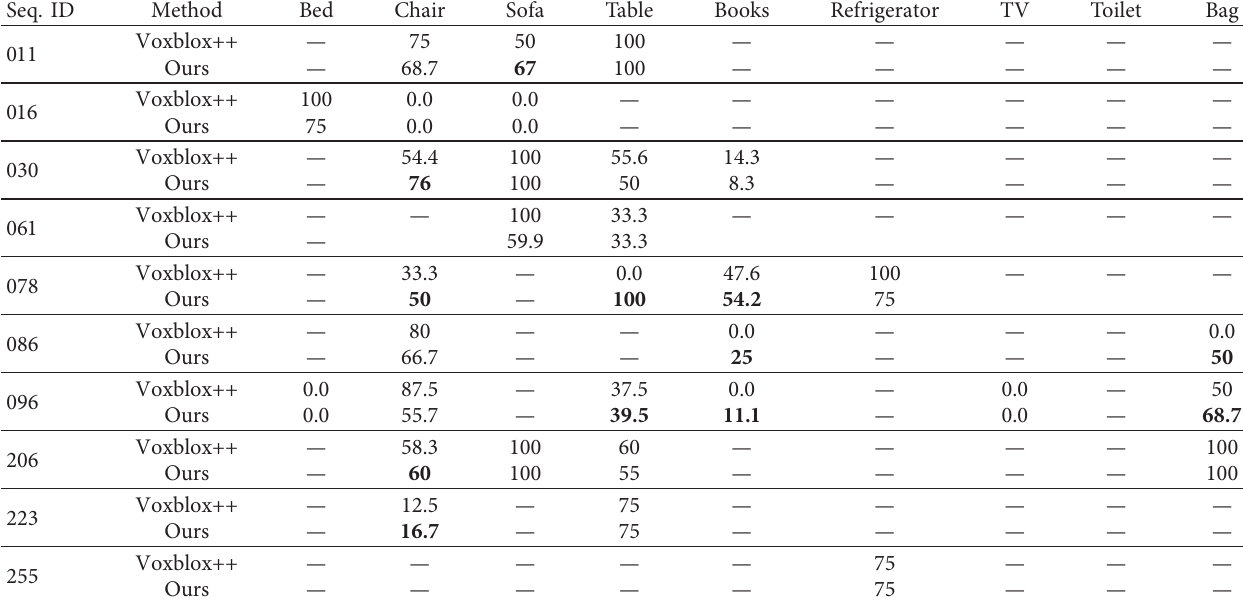
Table 2: Comparison to the 3D semantic instance segmentation approach from Voxblox++ [16] proposed by Grinvald et al. For 10 sequences from the SceneNN dataset [21], the per-class average precision (AP) is computed using an intersection over union (IoU) threshold of 0.5 over the predicted 3D segmentation masks.